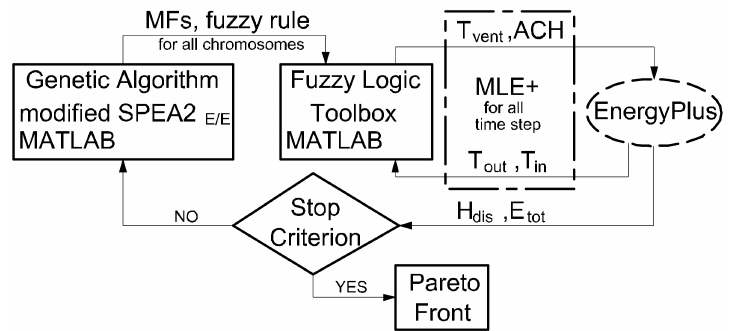
Figure 4. Flowchart diagram for the developed simulation/optimization tool.